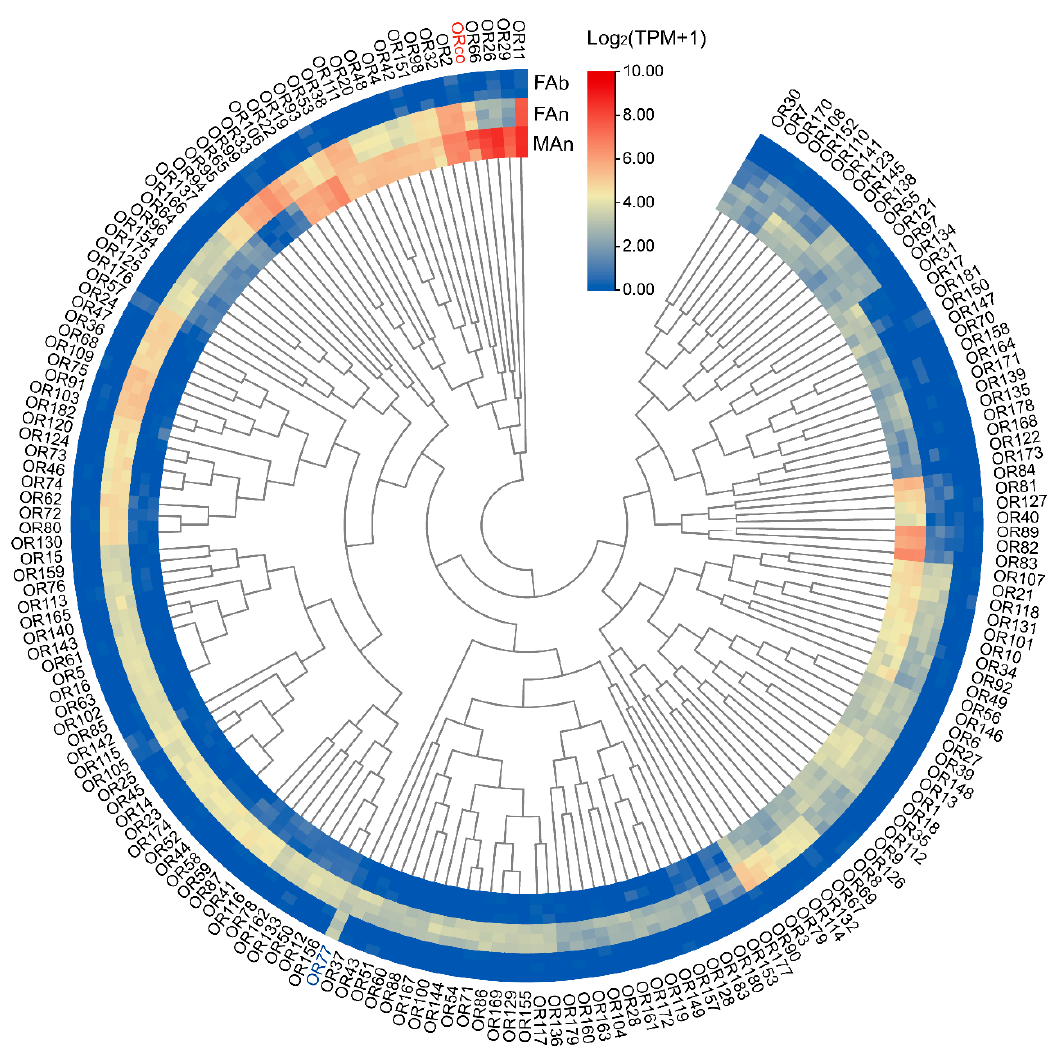
Figure 3. The expression profiles of AjapORs in the female abdomen, female antennae, or male antennae of Anastatus japonicus . The expression leves of genes were calculated based on log 2 (TPM+1). Similarly, the expression profiles of the 17 IRs were examined (Figure 5). The TPM val- ues for these genes ranged from 0.04 to 1.84 in the female abdomen (except for AjapGlu-R1B and AjapGlu-R1, which were 2.63 and 3.42, respectively), from 0.06 to 124.45 in the female antennae, and from 0.49 to 281.66 in the male antennae (Figure 5A). Among those expressed in the female, 15 IRs genes had upregulated expression in the antennae. The AjapGlu-R1B and AjapGlu-R1 were upregulated in the abdomen (Figure 5B). Among those expressed in both the female and male antennae, AjapIR25a.2 and AjapIR93a were upregulated in the female compared to the male, while eight IRs had upregulated expression in the male compared to the female (Figure